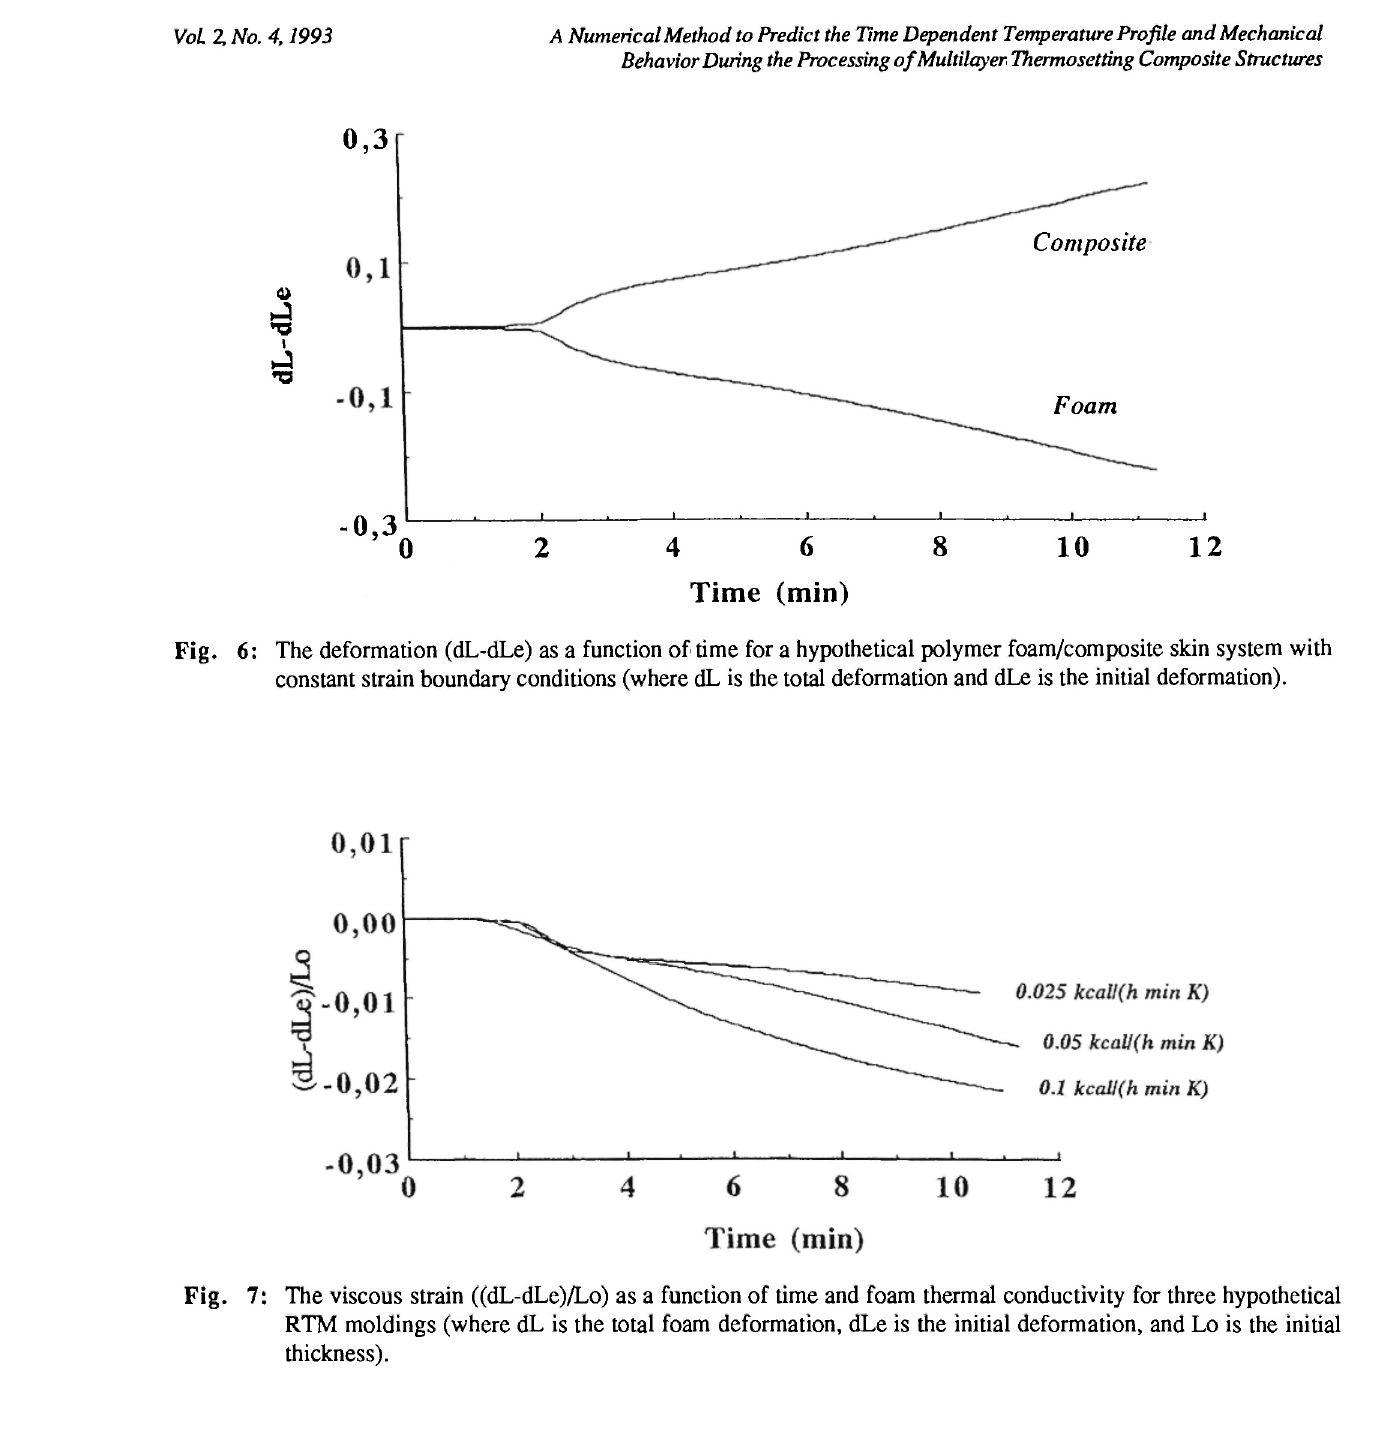
Fig. 7: The viscous strain ((dL-dLe)/Lo) as a function of time and foam thermal conductivity for three hypothetical RTM moldings (where dL is the total foam deformation, dLe is the initial deformation, and Lo is the initial